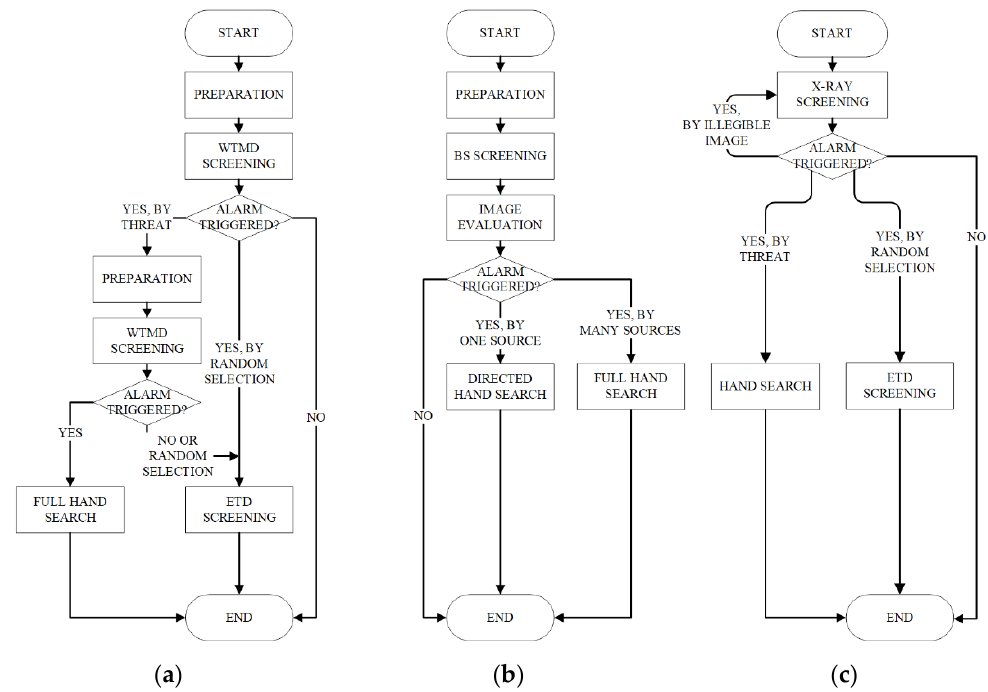
Figure 1. Simplified diagram of the passenger screening process: ( a ) procedure for passengers with the WTMD screening method, ( b ) procedure for passengers with the BS screening method, ( c ) procedure for hand luggage.